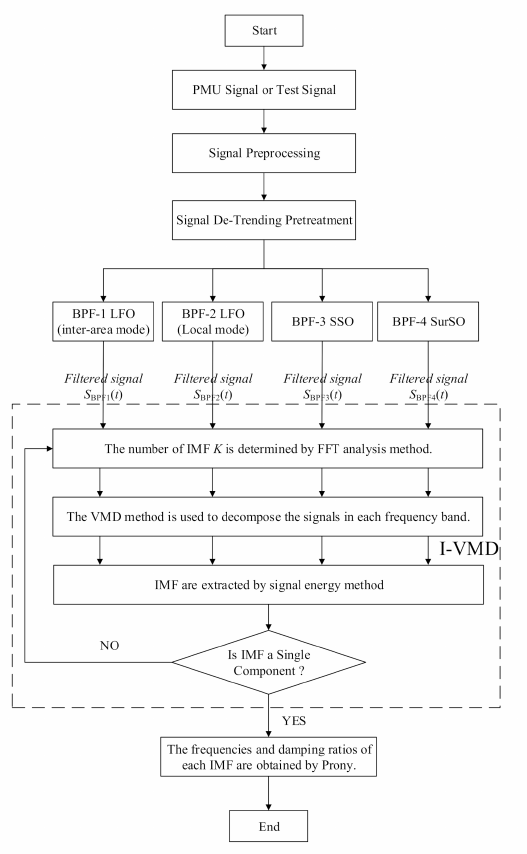
Figure 2. Framework of iterative adaptive variational mode decomposition (IA-VMD)-based broad- band oscillation